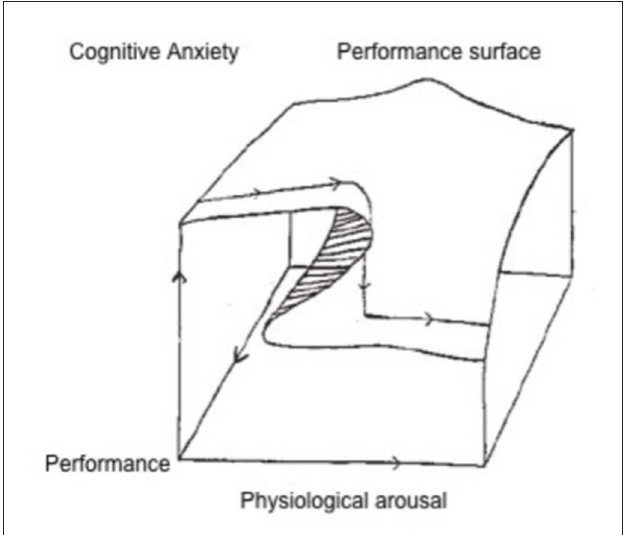
FIGURE1 Chaos theory (10). The performance surface relies on the integration of both cognitive anxiety and physiological arousal. While on the back the performance surface is barely affected by physiological arousal during low of cognitive anxiety; the front of the performance surface significantly drops during high cognitive anxiety when the physical arousal is great.